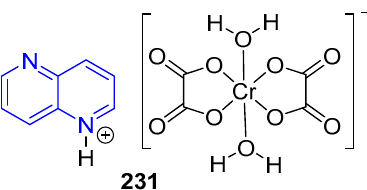
Figure 45. Chromium complex as semi-conductor.